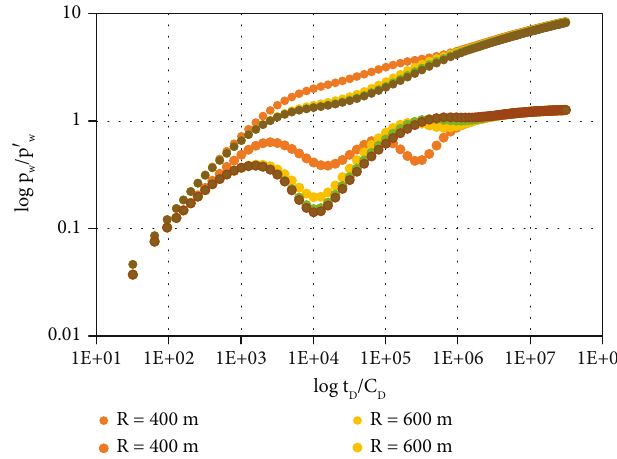
Figure 5: The in fl uence of inner zone radius on pressure di ff erence and pressure di ff erence derivative